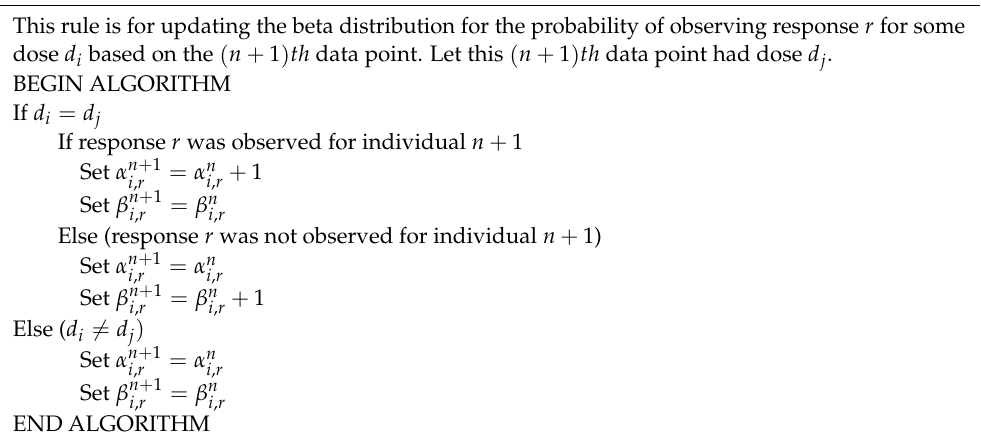
Algorithm 1. Update rule for uncorrelated Beta